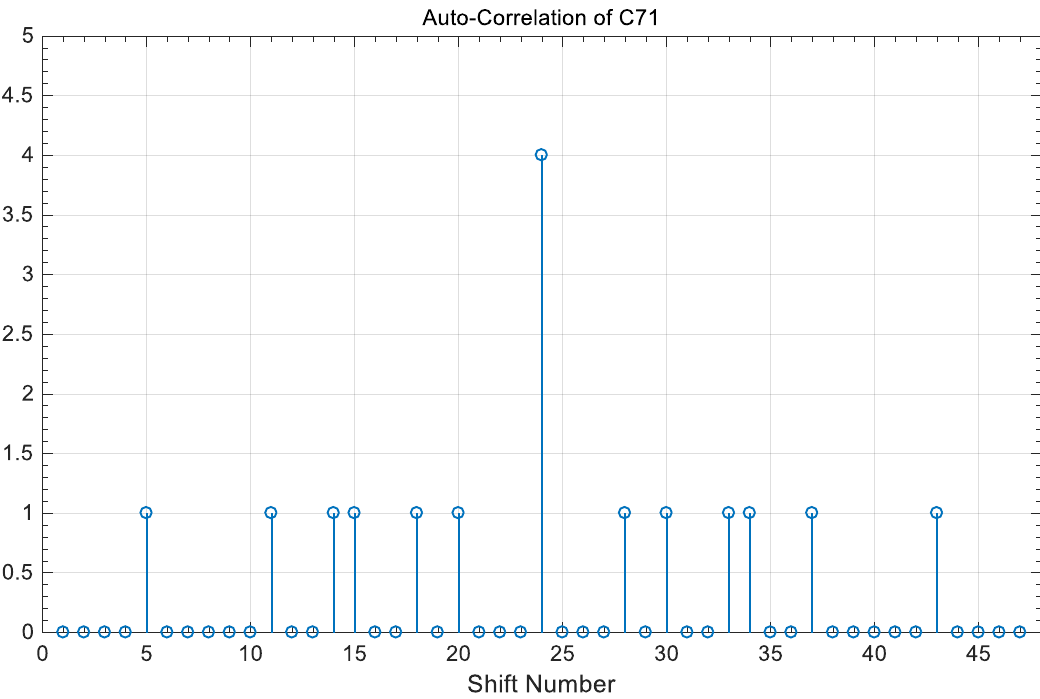
Figure 3. Auto-correlation of 𝐶 71 sequence, 𝑃 1 = 5 and 𝑃 2 = 7.